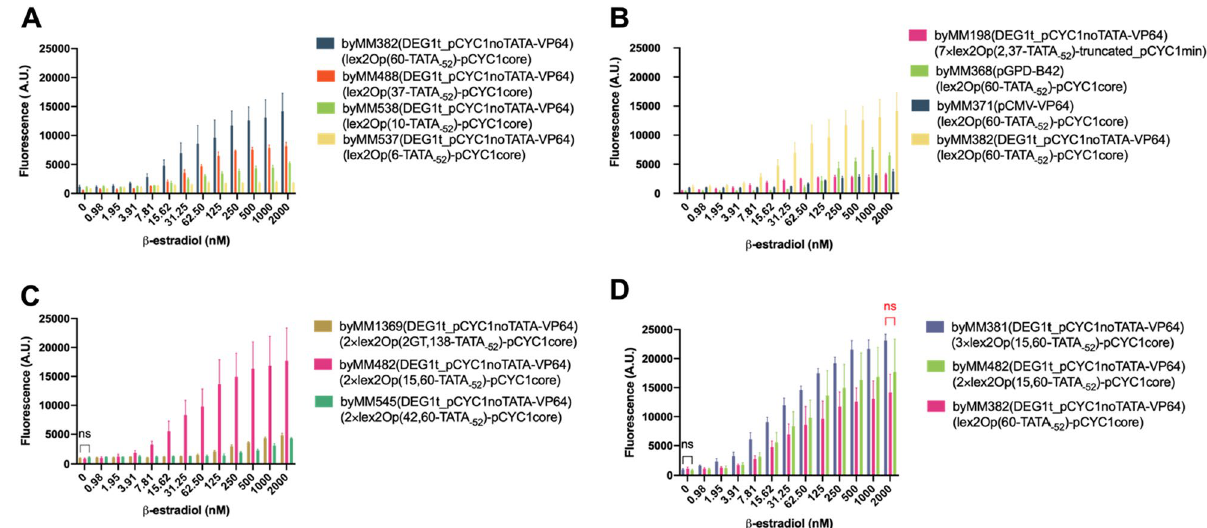
Figure 4. Response of biosensors 4–7 to increasing concentrations of β-estradiol. ( A ) Biosensors 4. A high distance—60 nt—between a single lex2Op and TATA -52 favors fluorescence expression. VP64 is probably the main responsible for the high basal fluorescence that went from 549.32 (byMM488) to 1142.28 A. U. (byMM382). ( B ) Biosensors 5. The receptor configurations pGPD-B42 (byMM368) and pCMV-VP64 (byMM371) fail to approach DEG1t_pCYC1noTATA-VP64 in the activation of a single lex2Op (byMM382). byMM371 reminds, at high concentrations of β-estradiol, byMM198. The latter, however, has a much higher detectivity (D = 3.91 nM instead of 125 nM). ( C ) Biosensors 6. A 15-nt distance between two adjacent lex2Op maximizes the output signal and guarantees a reasonably high detectivity. The three configurations have in common (no statistically significant difference—ns: p-value: 0.0810; one-way ANOVA) a rather high basal fluorescence, from 912.04 (byMM482) to 1136 A.U. (byMM545). ( D ) Biosensor 7. byMM381 fluorescence level is plotted in comparison with those of byMM482 (2×lex2Op) and byMM382 (lex2Op). The maximal mean fluorescence value of byMM381 is fairly higher than those of the other two biosensors (all at 2000 nM β-estradiol). However, there is no statistically significant difference between byMM381 and byMM482 maximal fluorescence level (ns: p-value = 0.0278; two-sided Welch’s t-test) due to the high standard deviation associated in contrast, much higher than that of the other two biosensors (7.81 nM β-estradiol). We tested similar cassettes of lex2Op also in front of the truncated_pCYC1core promoter (biosensors 10, see Fig. S15). The results are shown in Fig.